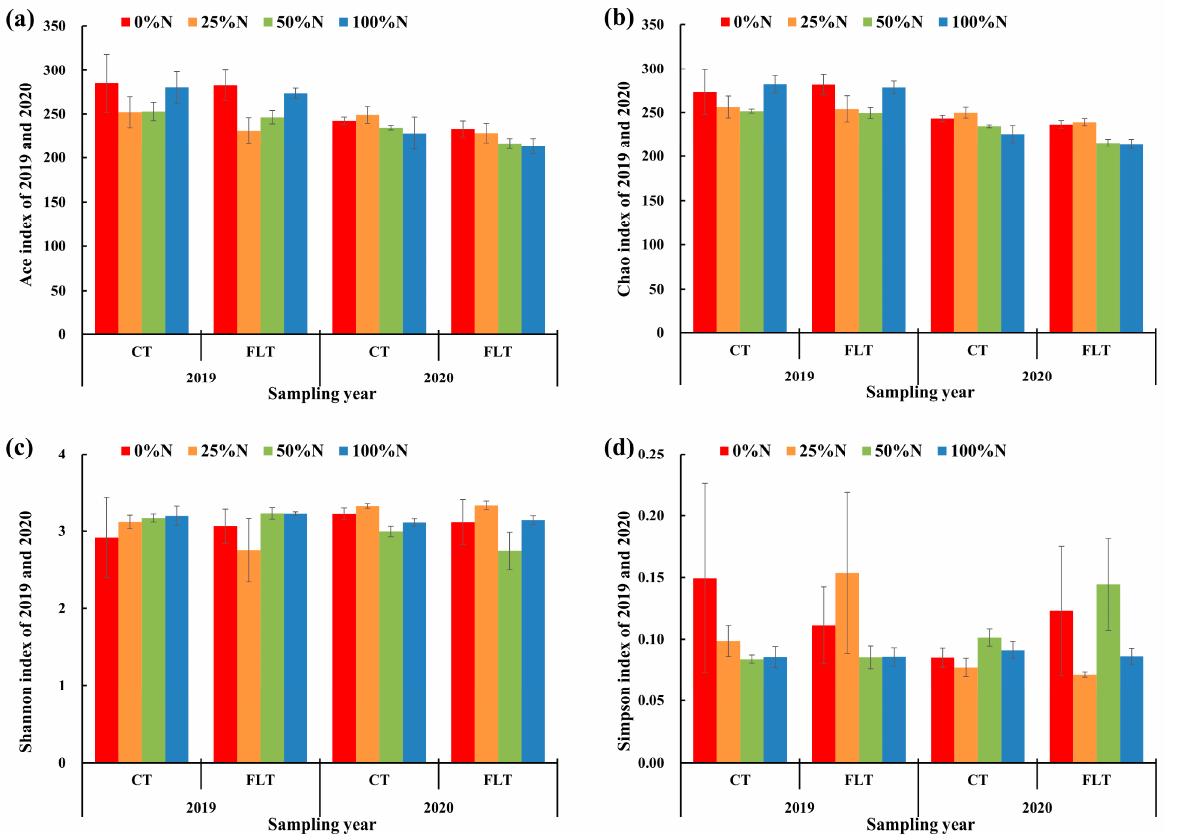
Figure 2. Fungal alpha diversity indices of cassava rhizosphere soil collected in 2019 and 2020,